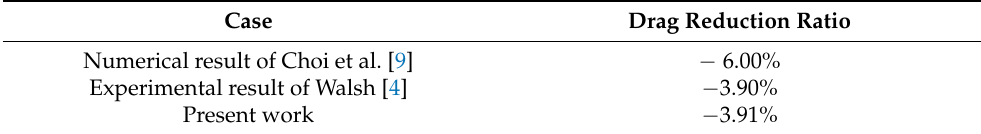
Table 1. Drag reducing effect obtained by the modified SST-RC